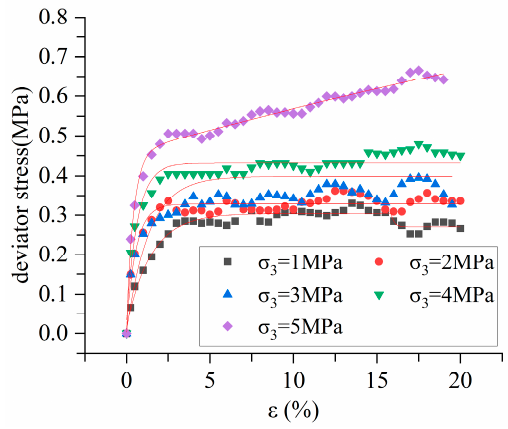
Figure 6. Triaxial stress–strain curves of sediments.